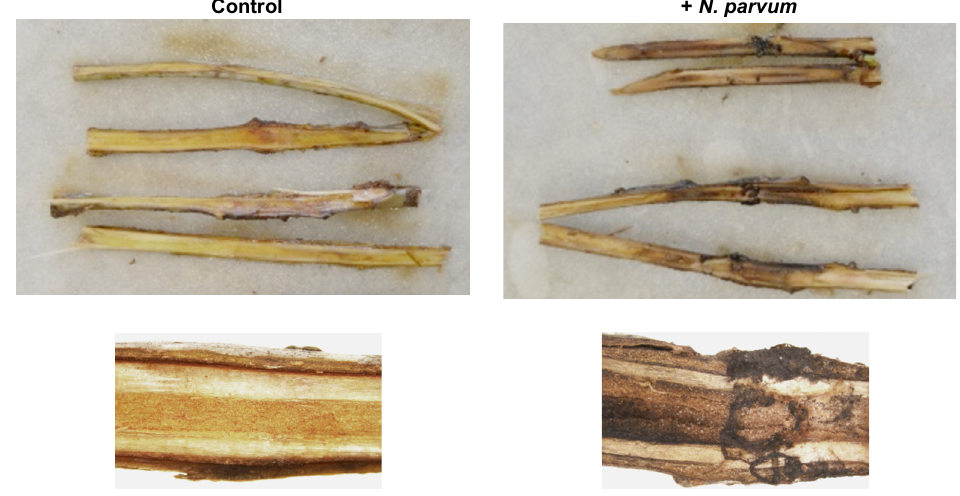
Figure 5. Infection of L. styraciflua fresh stems with N. parvum . The photographs were taken at 7 dpi.